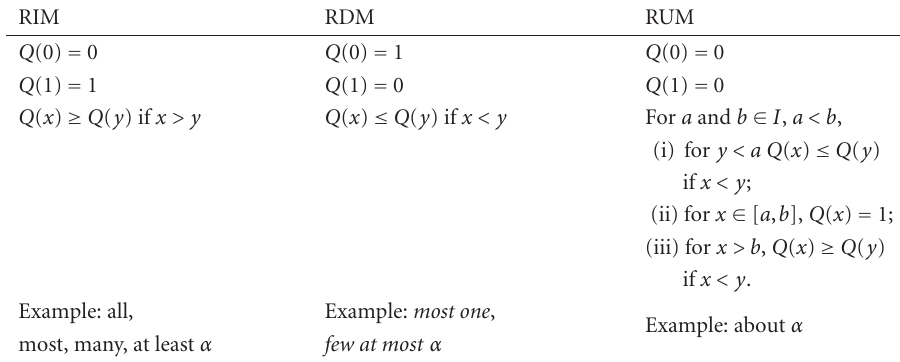
Table 2.1. Properties of various monotonic